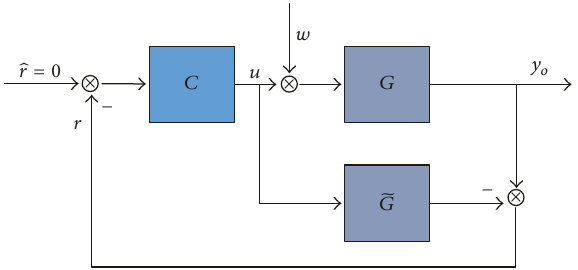
Figure 4: Equivalent IMC structure of teleoperation